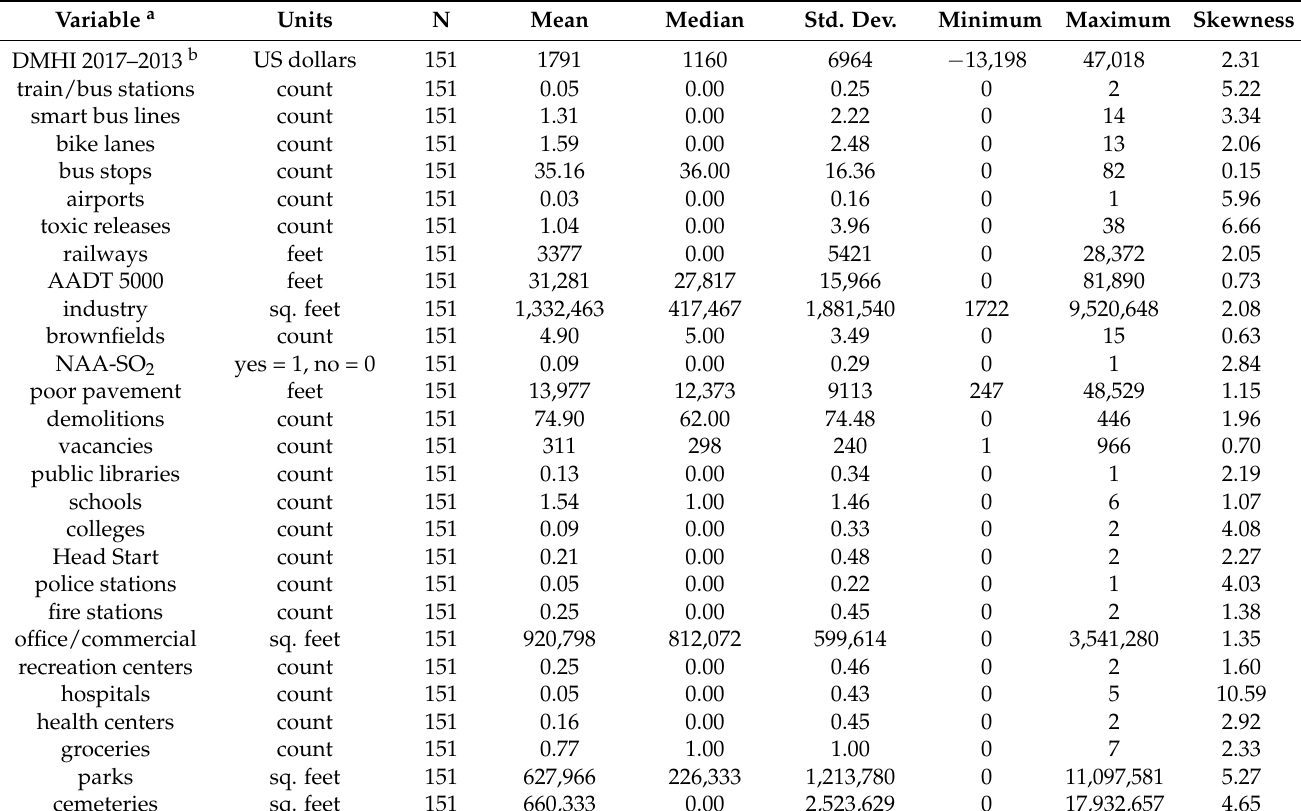
Table 1. Descriptive statistics of all variables based on data in each grid cell.